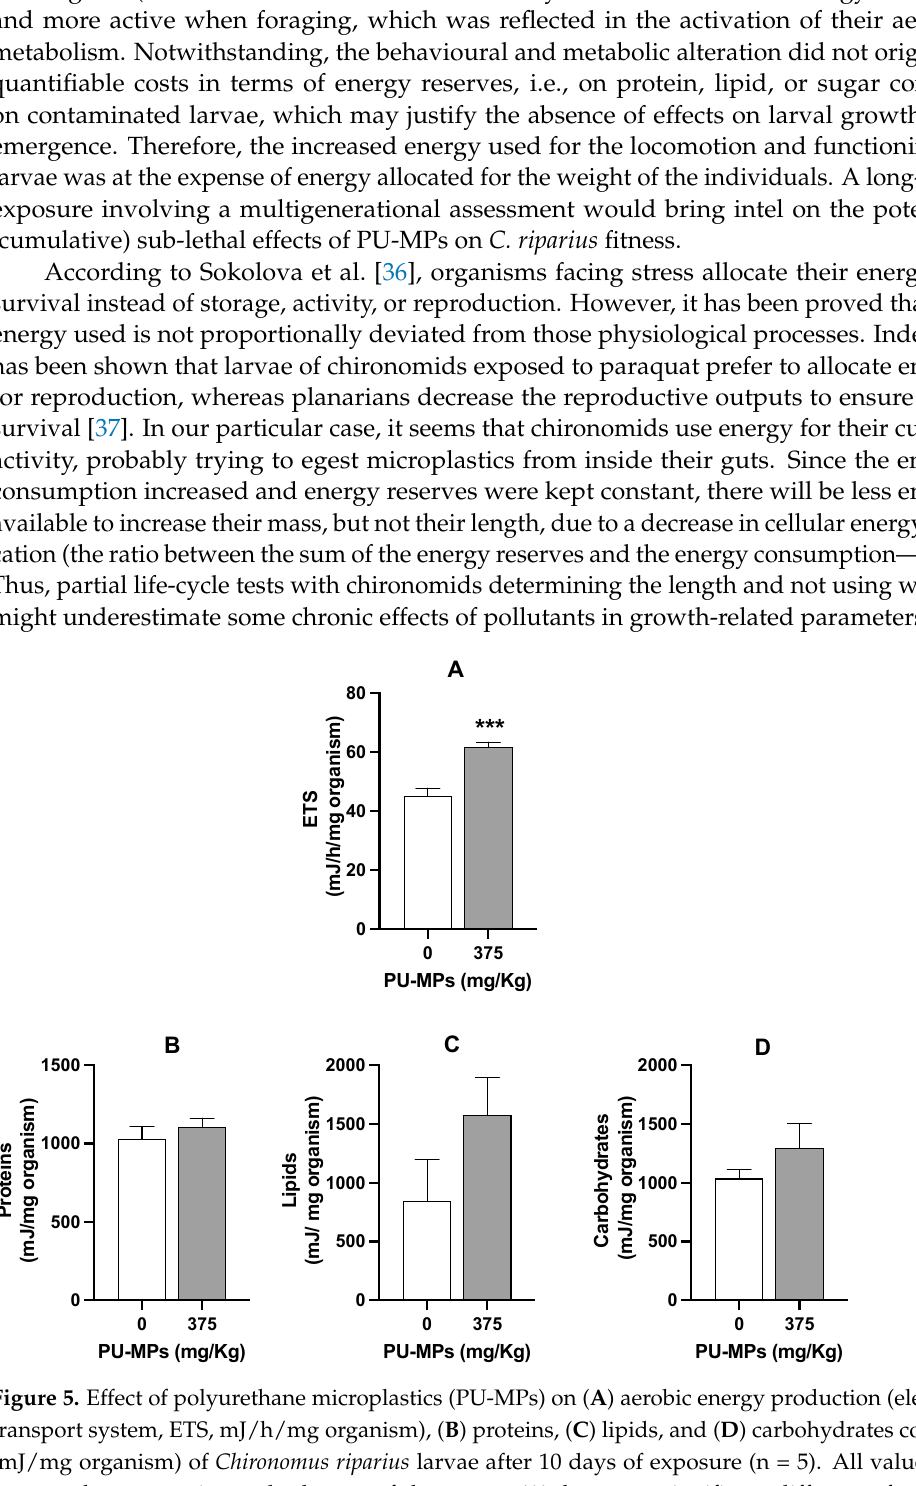
Figure 6. Lipid peroxidation (LPO) levels in Chironomus riparius larvae after 10 days of exposure to polyurethane microplastics (PU-MPs) (n = 5). All values are presented as mean ± standard error of the mean. No significant differences between treatments were denoted. 4. Conclusions This study showed that exposure to environmentally relevant concentrations (up to 750 mg/kg) of PU-MPs (a thermoset plastic) with a size between 7.0 and 9.0 μ m seemed to induce sub-lethal effects on larvae of the freshwater dipteran Chironomus riparius , consid- ering their decreased weight and abnormal high curling/uncurling rate. These effects are clear signs of toxicity at the organism level. Nevertheless, contaminated larvae were re- vealed to be lighter (but not smaller) and more active when foraging, which was reflected in the activation of their aerobic metabolism. Notwithstanding, no alteration in energy reserves (proteins, carbohydrates, or lipids) was observed, which may justify the absence of effects on larval length and emergence. Thus, it seems that larvae ingesting PU-MPs